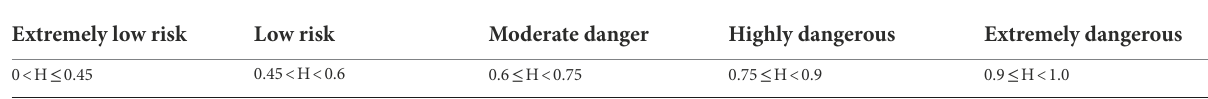
TABLE 8 Debris flow risk classification standard in the quake-hit